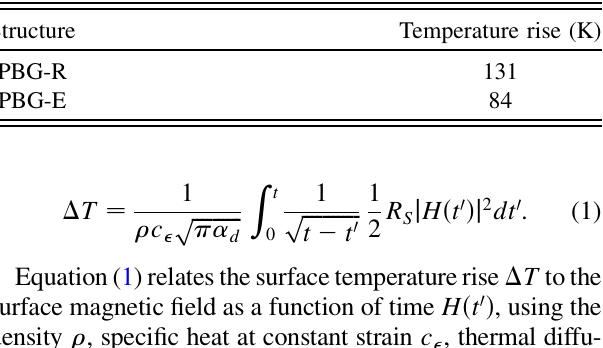
FIG. 8. S 11 of PBG-E structure, showing resonances for, in order of increasing frequency, the 0 mode, the (cid:4)= 2 mode, and the (cid:4) mode.